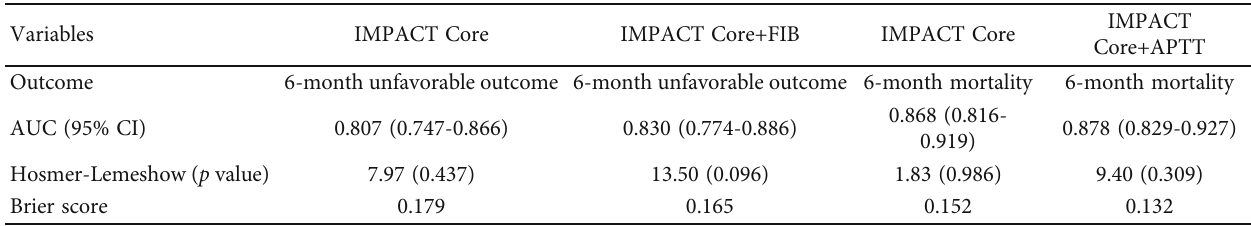
Table 5: Performance of models.